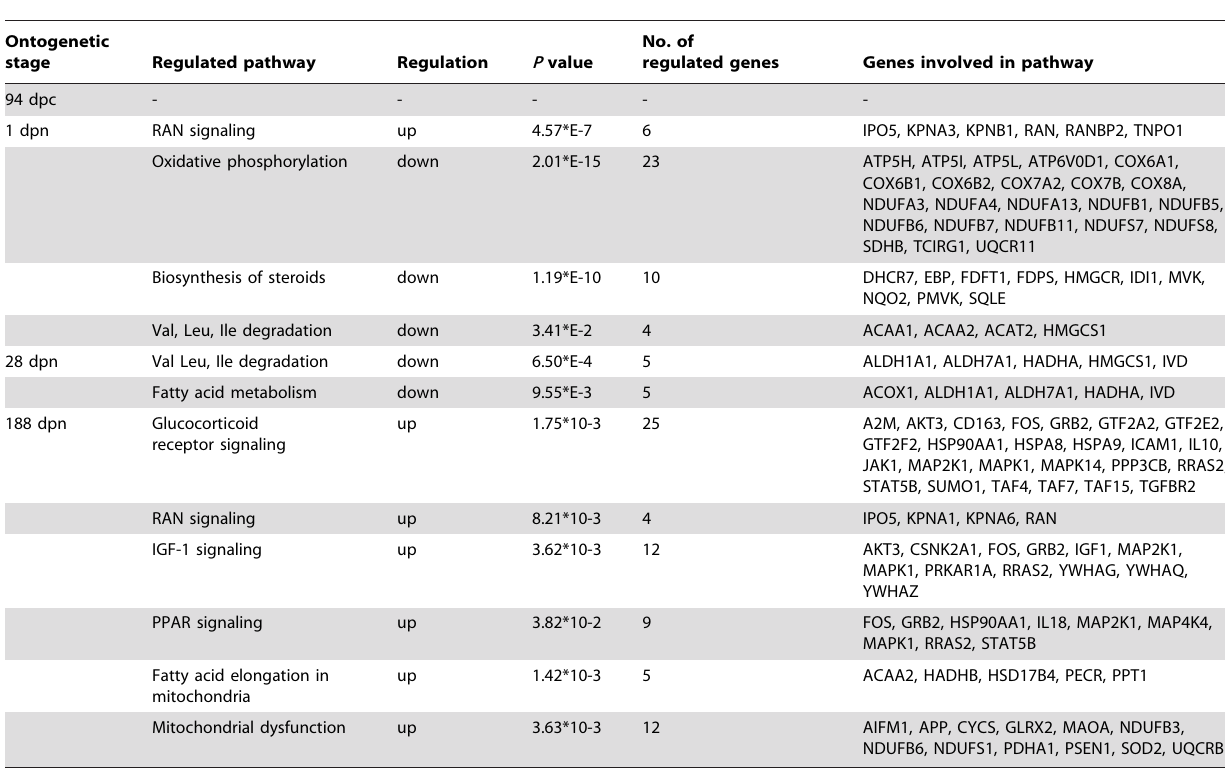
Table 1. Significantly regulated transcripts of metabolic pathways in liver tissue within different ontogenetic stages (Ingenuity Pathway